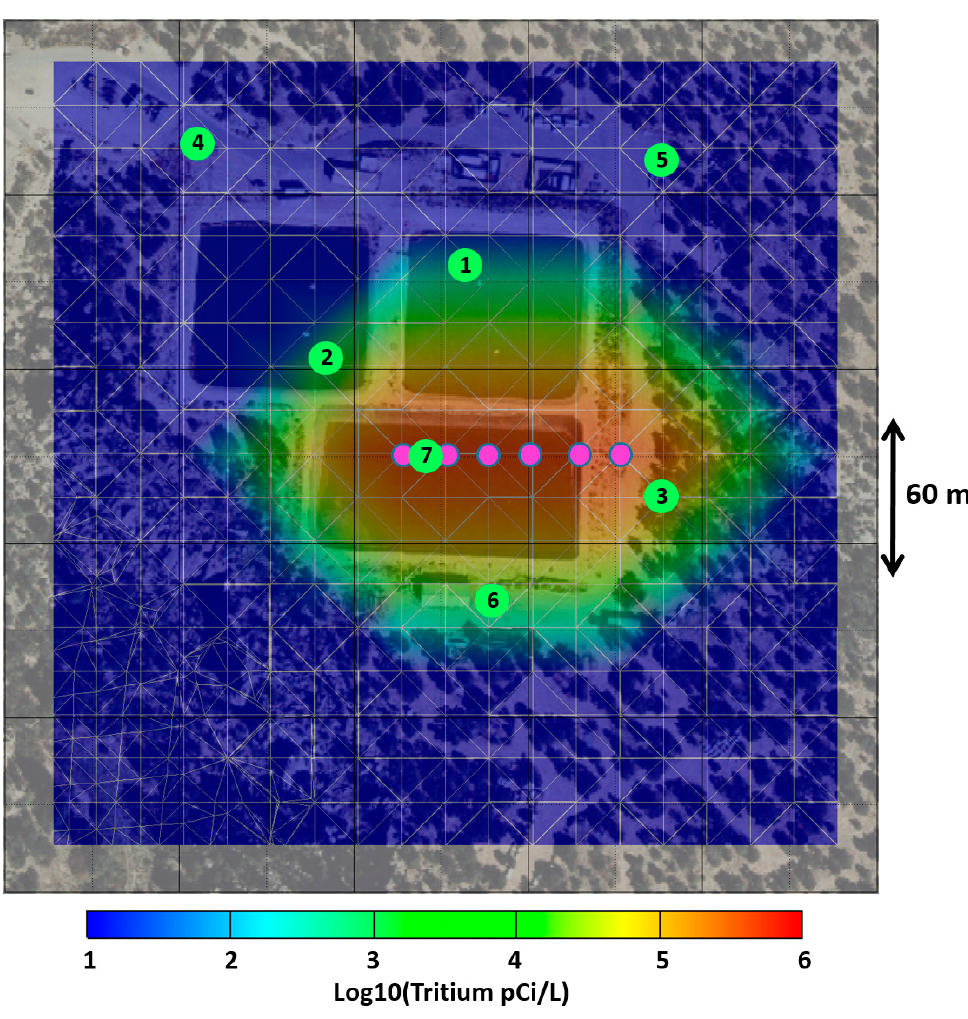
Figure 7. Image of the surface impoundments before they were removed. The numerical grid is overlain on the photo. The color contours are the simulated tritium plume at 2088 m elevation for the bounding case. The six pink dots show the location of the simulated leakage (injection) along the unlined drainage ditch. The green circles are the locations of Boreholes 1–7 drilled in 2002.